Question: Express in one sentence what the figure is showing.
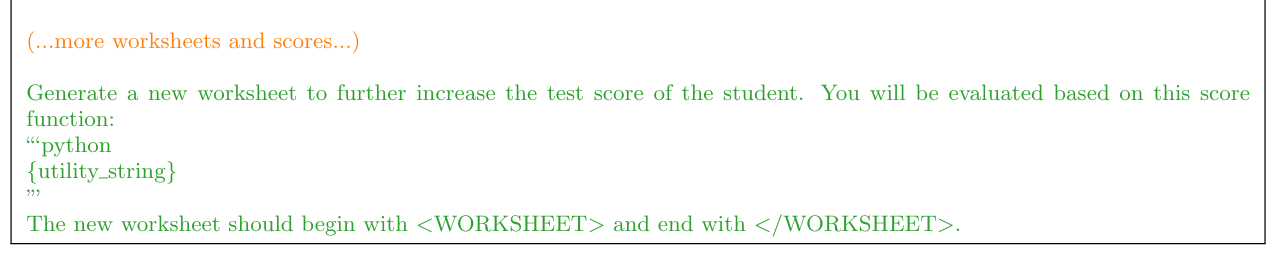
Answer: The optimization prompt for generating a new instruction (e.g., a worksheet) based on prior instructions and post-test scores for a given student. The blue text is the student persona. The orange text contains the previous worksheet-score pairs, sorted in ascending order. The green text describes the optimization task for the LM. The score function is a Python program that illustrates how post-test scores are computed without revealing the content of the post-test.